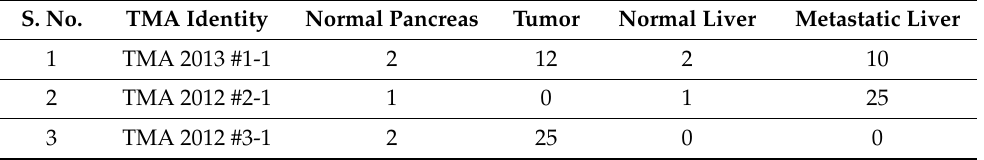
Table 1. Number and type of specimen in different TMA utilized in the study. S.